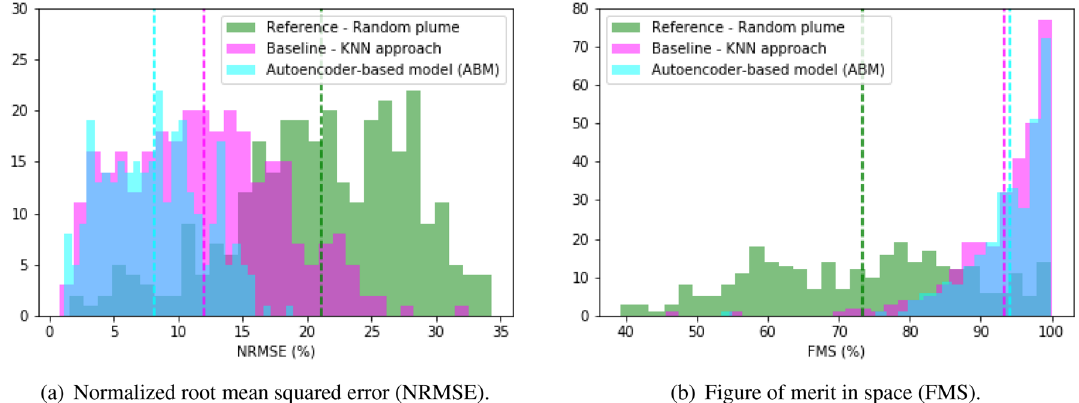
Figure 6. Performance metrics. The results are shown as histograms, highlighting the mean for each model, namely ABM, baseline, and reference. Each count corresponds to one of the 300 test preferred rather the ROC AUC because the former does not consider the performance on the negative class. On average, the images in our dataset have a 74% of white pixels (negative class) against an average of 26% of black pixels (positive class) making it an imbalanced dataset. The mean PR AUC for each of the three models is 0.93 for the ABM, 0.79 for the baseline model (KNN approach), and 0.14 for the reference model (random plume). The PR AUC curve is related to the FMS score in that the intersection component in Eq. (2) captures true positives, while the non-overlapping areas in the union capture false negatives and false positives.